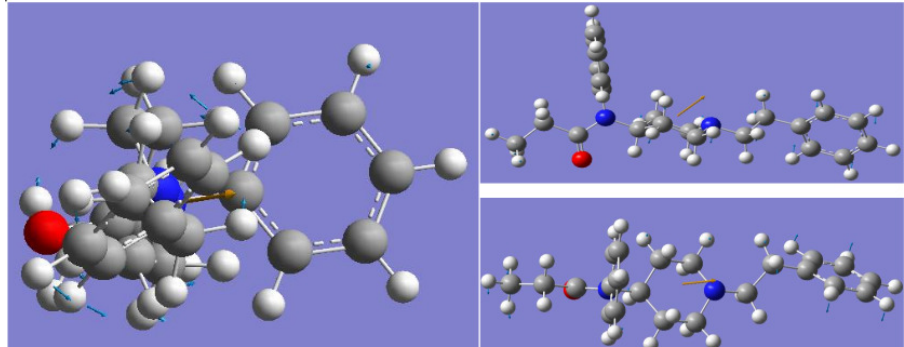
Figure 1. Absorption lines of fentanyl.